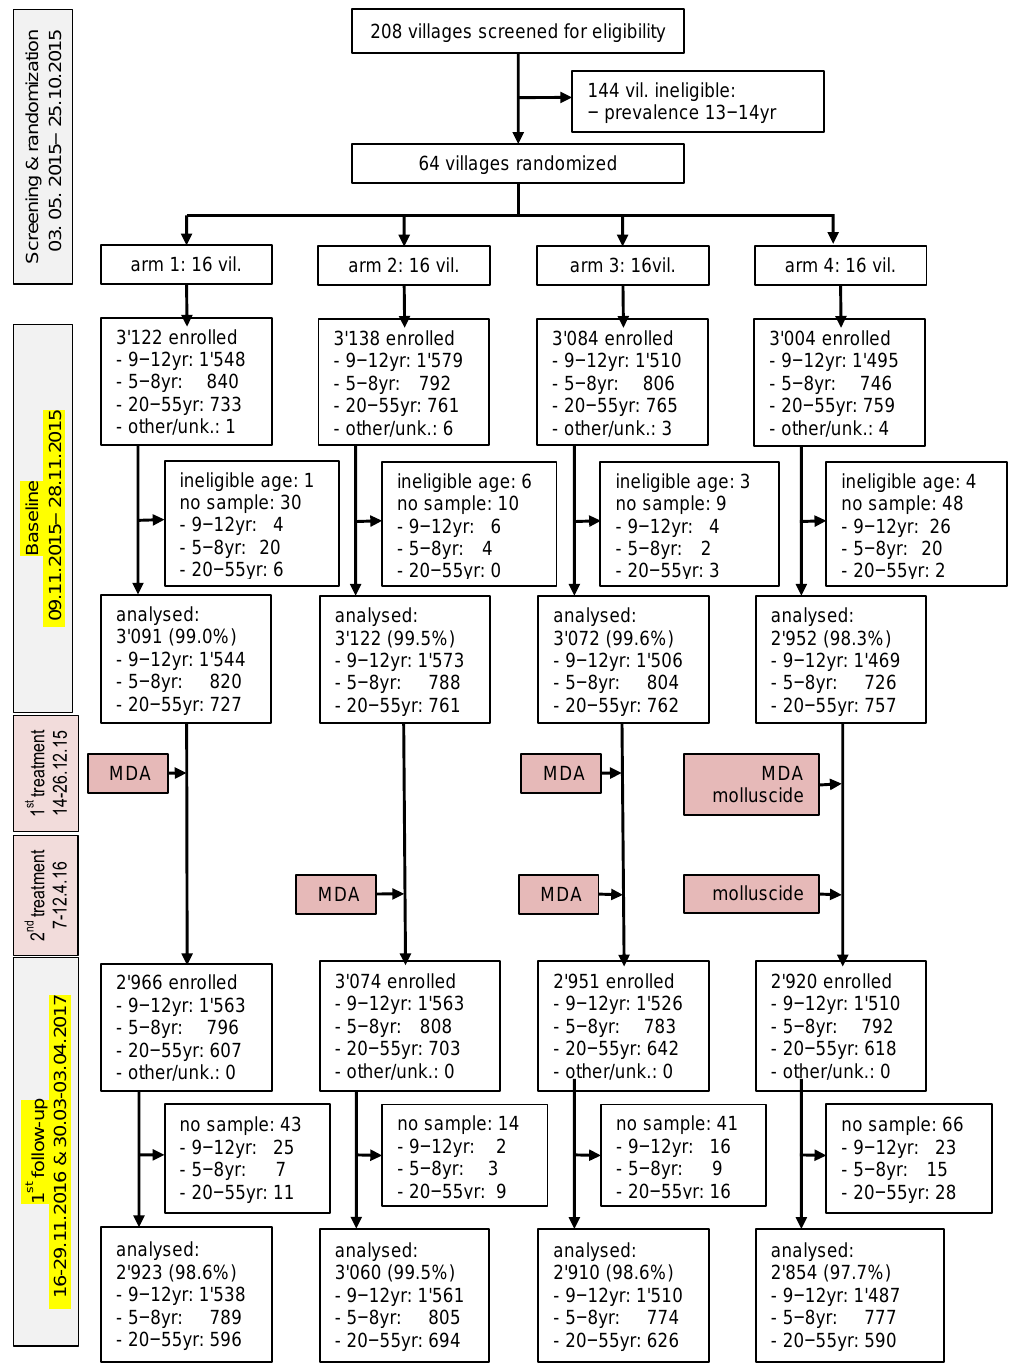
Figure 2. Study flow